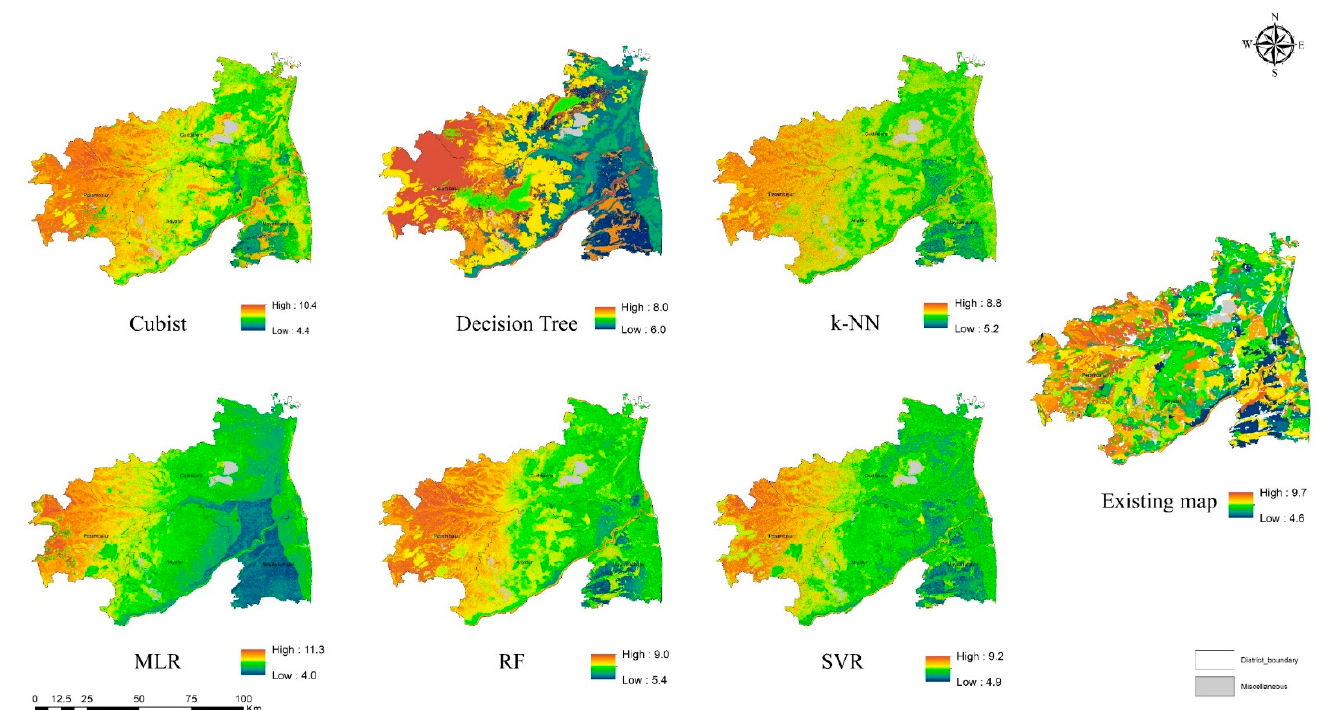
Figure 2. Existing and predicted maps of pH using different machine learning algorithms.